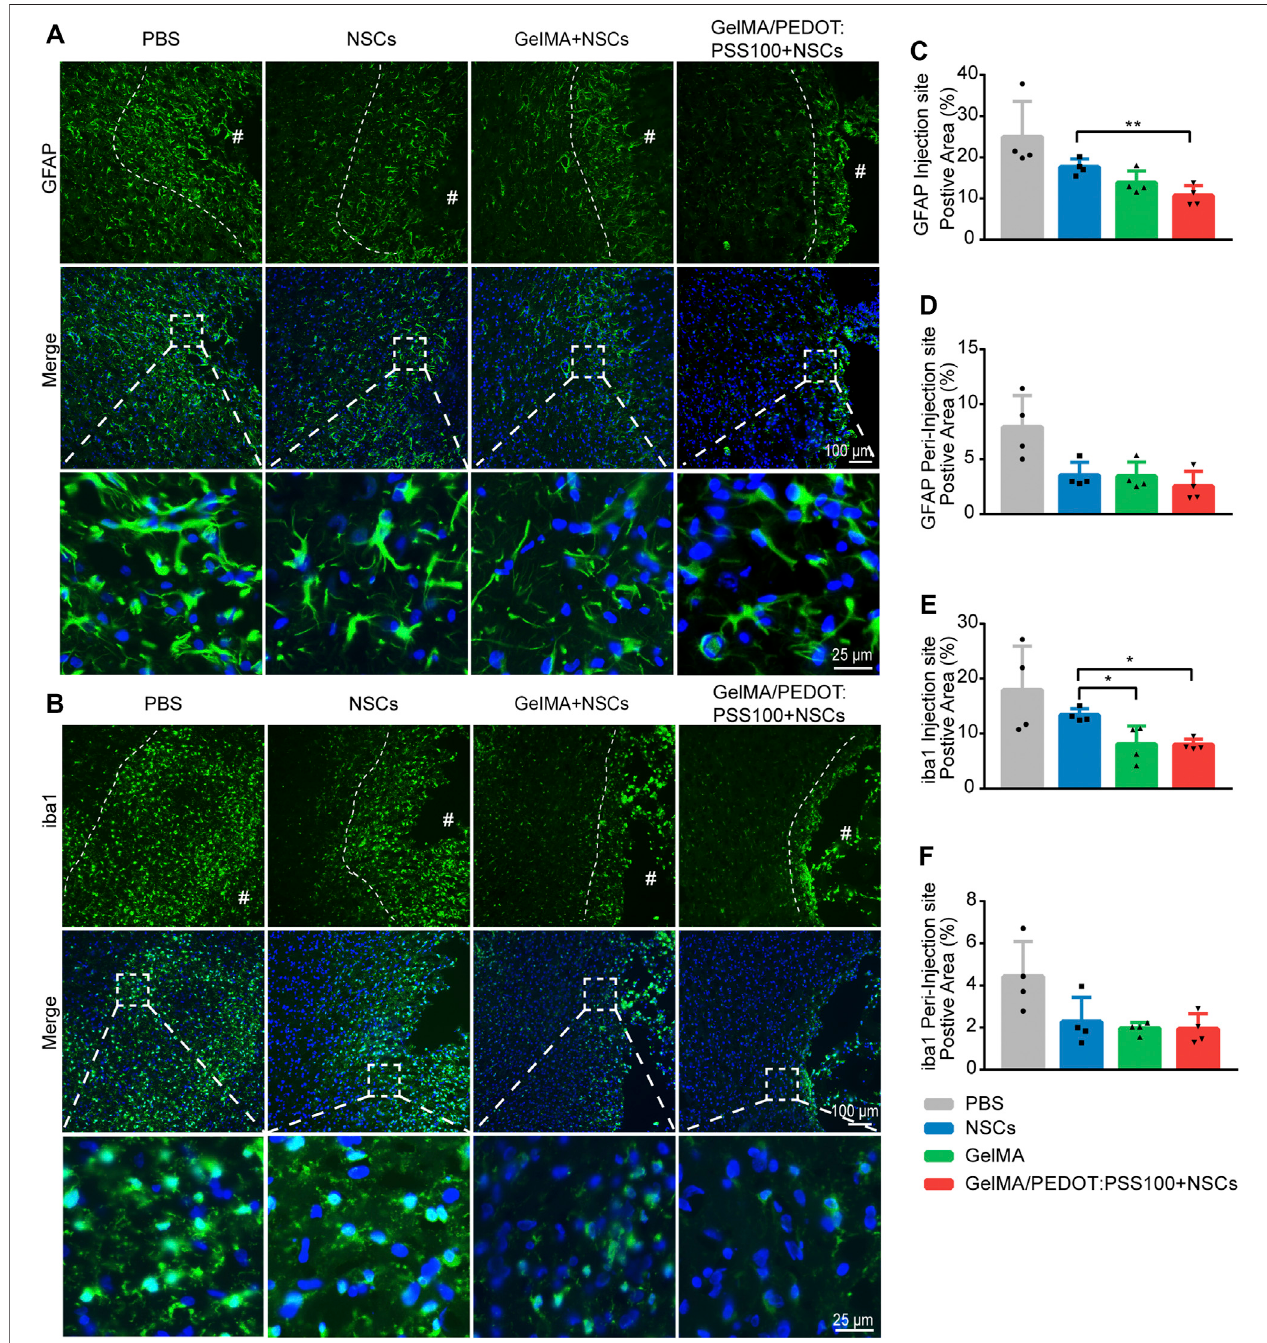
FIGURE 7 | In fl ammatory response of the conductive hydrogel-loaded NSCs to cerebral I/R injury. Fluorescent images of (A) astrocyte (GFAP) and (B) microglia (iba1) staining in rat brain tissues close to the injection and peri-injection sites. The dotted lines indicate the proliferation area ofastrocytes and microglia surrounding the siteofinjection.QuantitativeanalysisofGFAPpositiveareaattheinjection (C) andperi-injection (D) sites.Quantitativeanalysisofiba1positiveareaattheinjection (E) and peri-injection (F) sites. The data are expressed as mean ± SD. * p < 0.05 and ** p < 0.01.